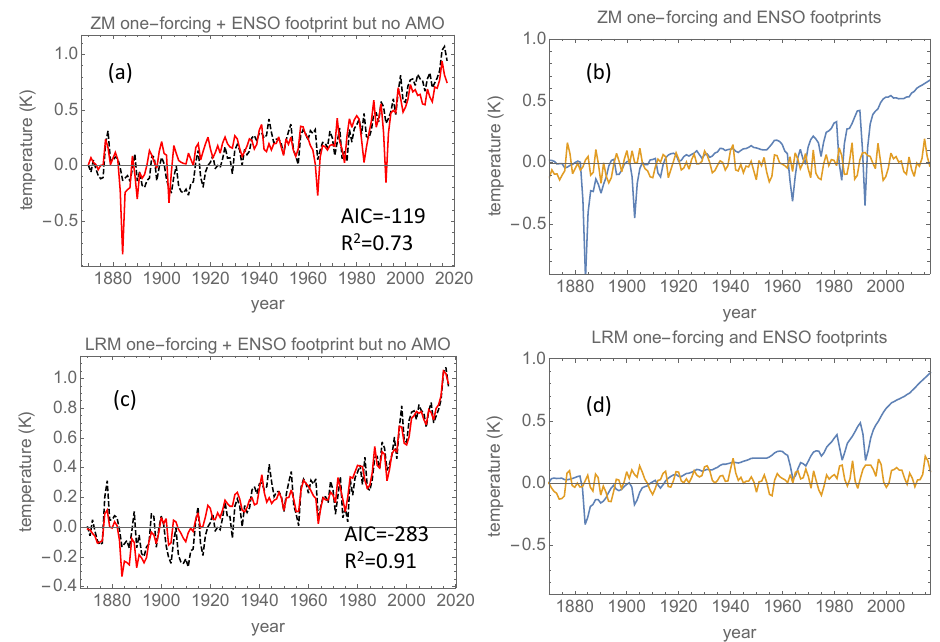
Figure 6. ( a ) The red curve is the total explained GMST (or the total footprint) from the regression where the fingerprints are the unfiltered total forcing and ENSO index. The black, dashed curve is the HadCrut4 GMST signal. ( b ) The individual footprints whose sum is the red curve in panel ( a ). The blue curve is the total forcing and the yellow curve represents the ENSO footprints, respectively. Panels ( c , d ) show the results of the same analysis as panels ( a , b ), but with fingerprints filtered with β = 0.6.